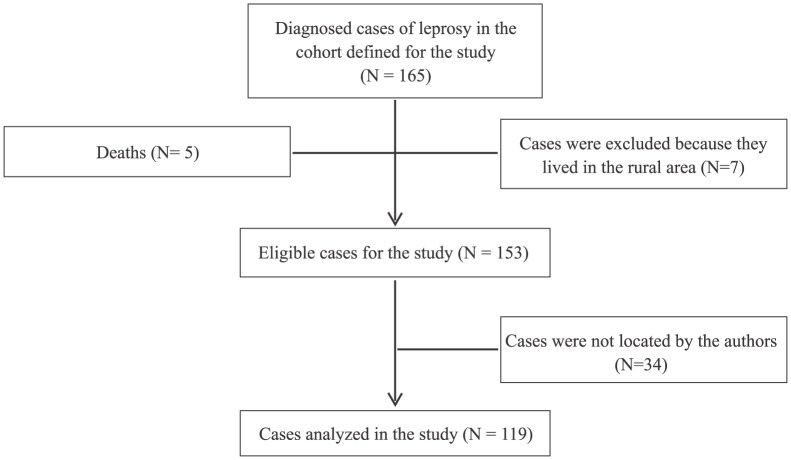
Flow chart of eligible and selected participants for the study, Londrina, Paraná, Brazil.